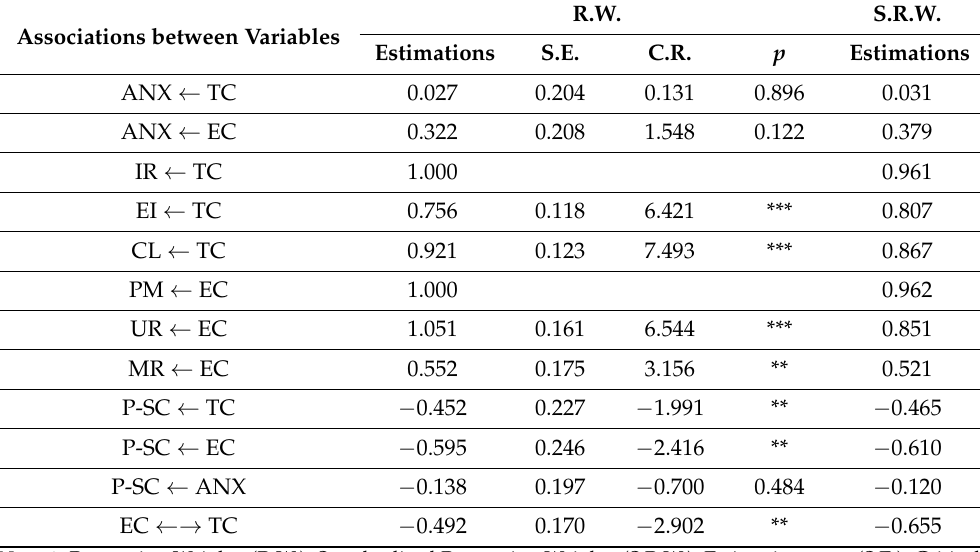
Table 4. Structural model for high adherence to the Mediterranean Diet. Associations between Variables